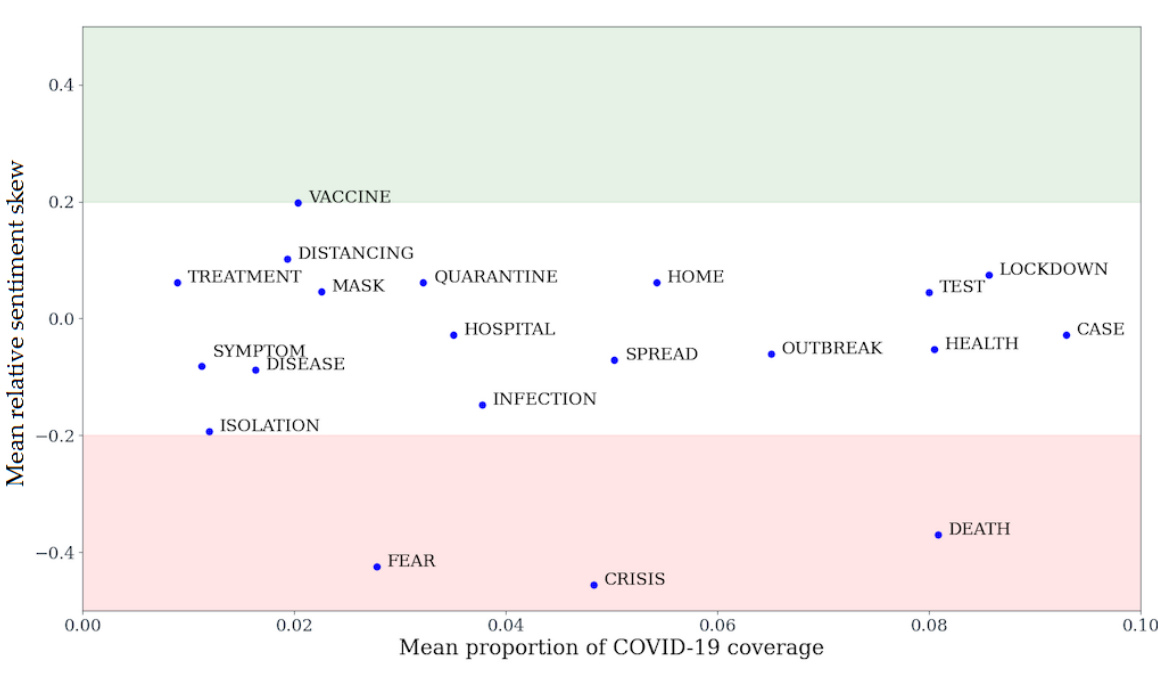
Figure 3. COVID-19 subtopic coverage and sentiment means. We calculated the mean coverage and mean sentiment of each subtopic. Coverage is expressed as the mean of ratios of subtopics in a given online news source against all COVID-19 articles in the same online news source. Sentiment is the mean of the subtopic relative sentiment skew for all online news sources. The shaded areas illustrate regions with relative sentiment skew above 0.2 (green), between 0.2 and –0.2 (white), and below –0.2